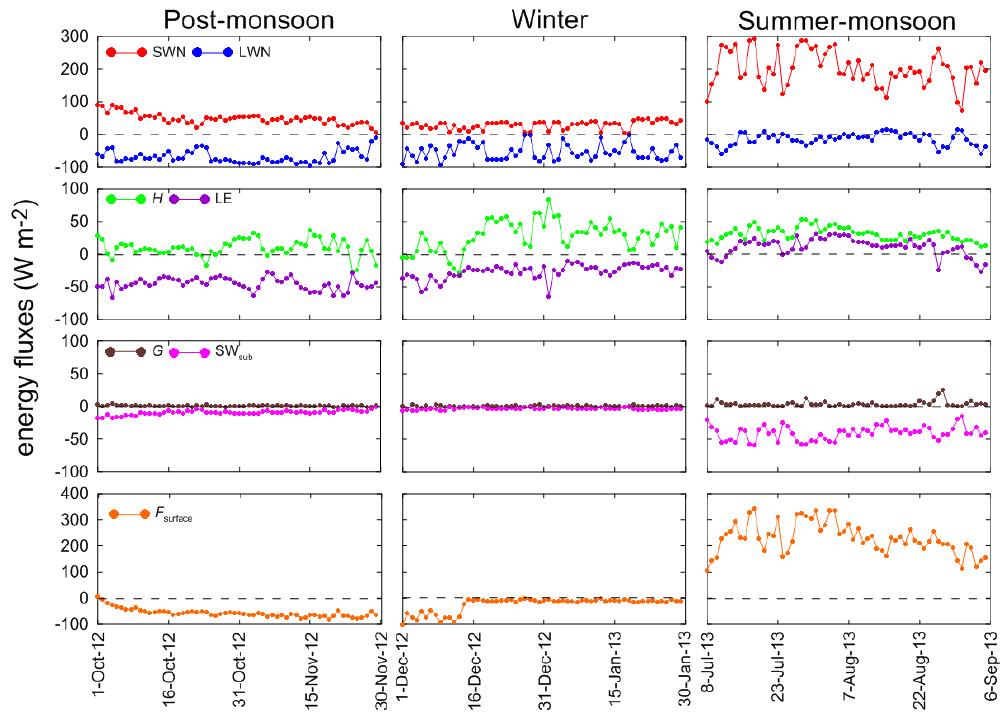
Figure 10. Daily values of the surface energy fluxes at AWS1 (4670ma.s.l.) as representative of post-monsoon (1 October to 29 Novem- ber 2012), winter (1 December to 29 January 2013) and summer-monsoon (8 July to 5 September 2013) periods. SWN, LWN, H , LE, G , SW sub and F surface are the net shortwave radiation, the net longwave radiation, the turbulent sensible and latent heat fluxes, the conductive heat flux, the shortwave radiation penetrating below the surface, and the amount of energy available at the surface,